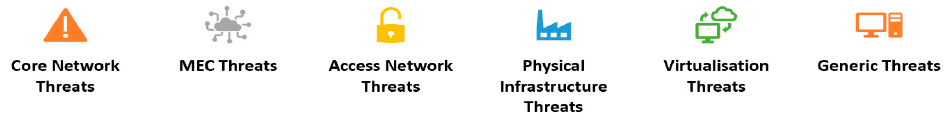
Table 6. Various standards illustrating different aspects of ICS/SCADA security [110].